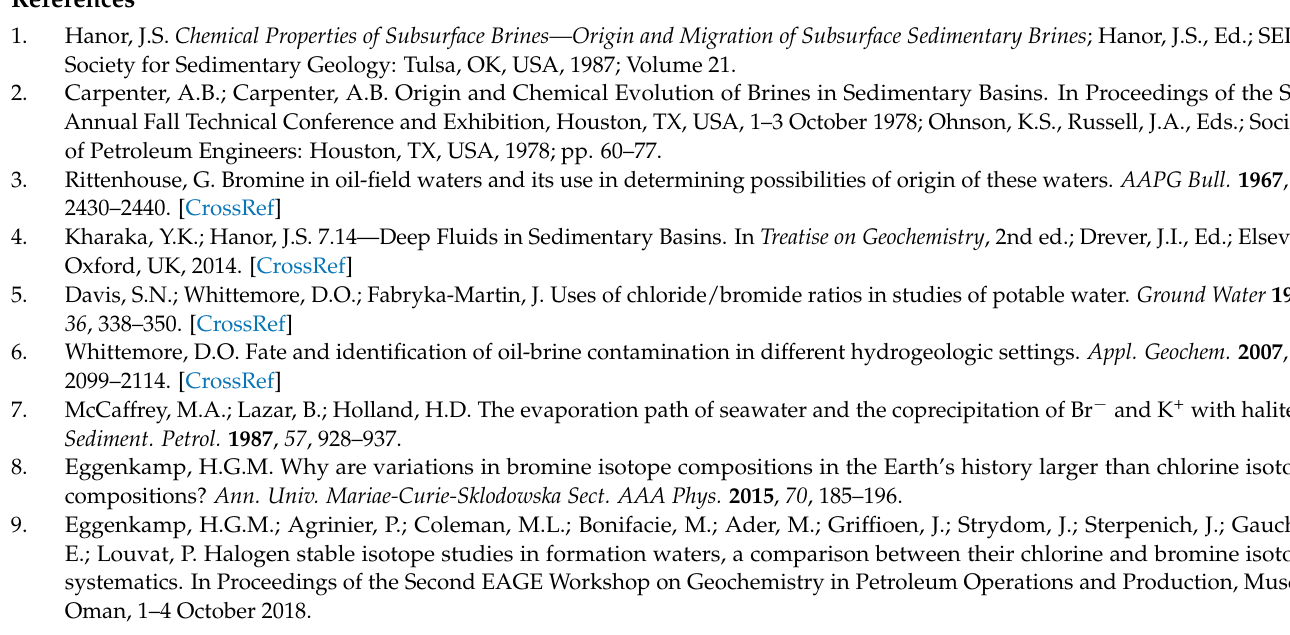
(bgs = below ground surface) and (b) end of hole (EOH) elevation (AMSL = above mean sea level); δ 81 Br vs. (c) depth and (d) EOH elevation; and 87 Sr/ 86 Sr vs. (e) depth and (f) EOH